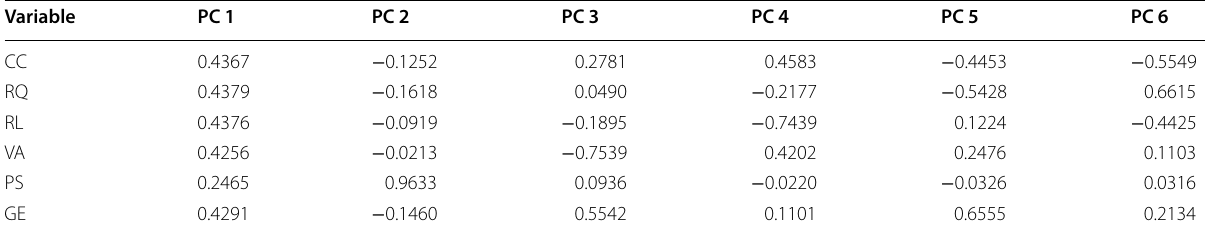
Table 4 Eigenvector